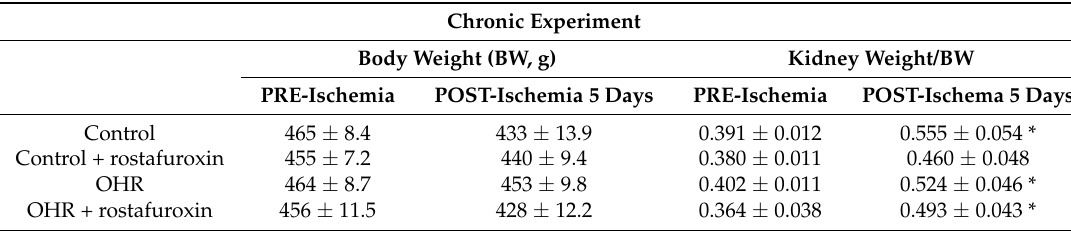
Table 1. Mean body weight and kidney weight of rats from the chronic experiment.